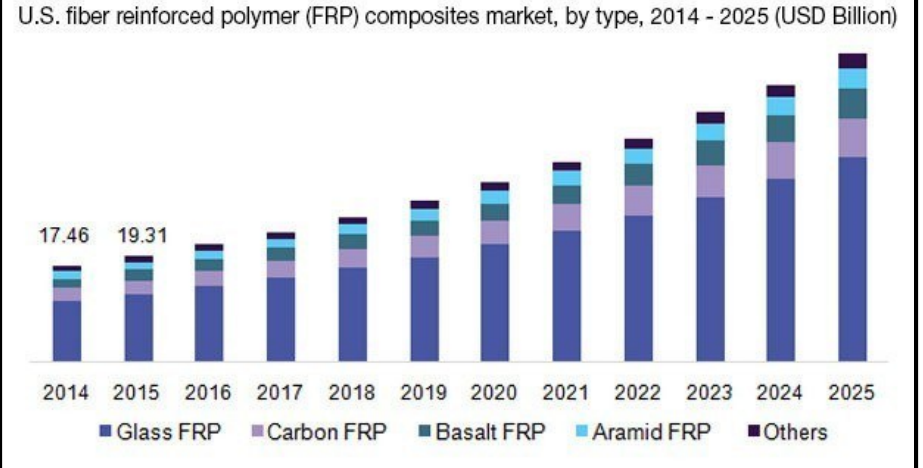
Figure 2. Forecast of the global growth of the FRP composite market, 2014–2025 [16].